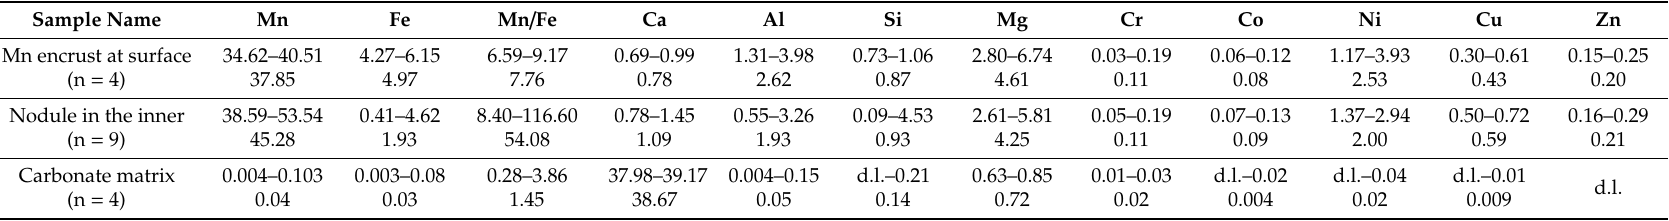
Table 1. Average chemical composition in wt.% obtained with the electron probe micro-analyzer (EPMA) of studied Mn oxides and the carbonate